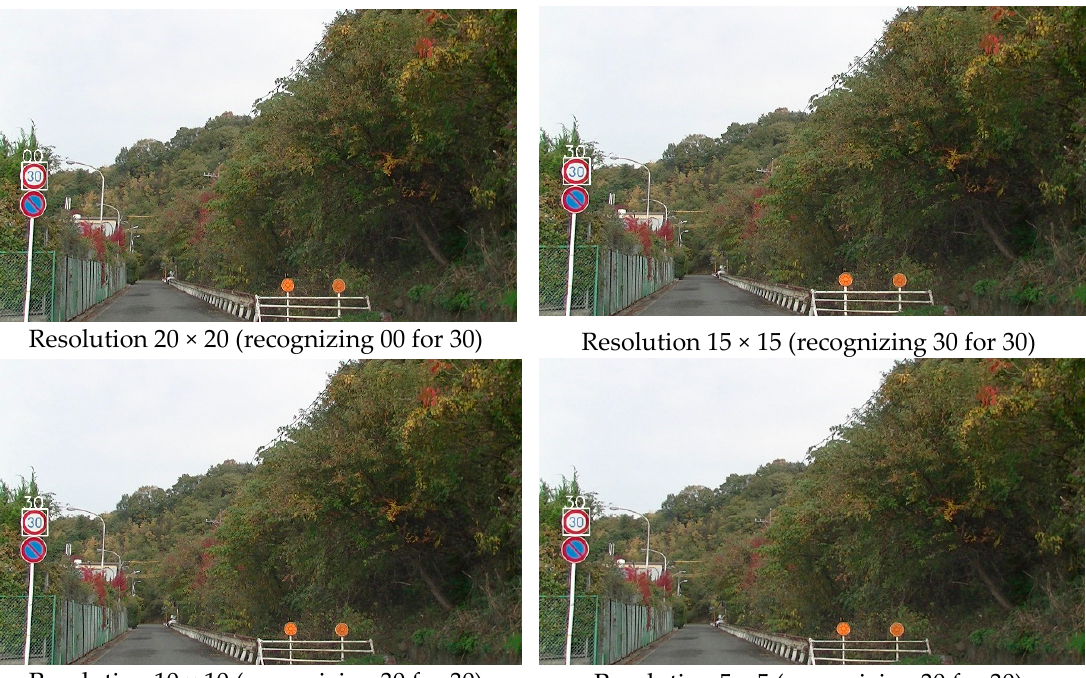
Figure16. Three feature quantities at each resolution for the extracted number 50.